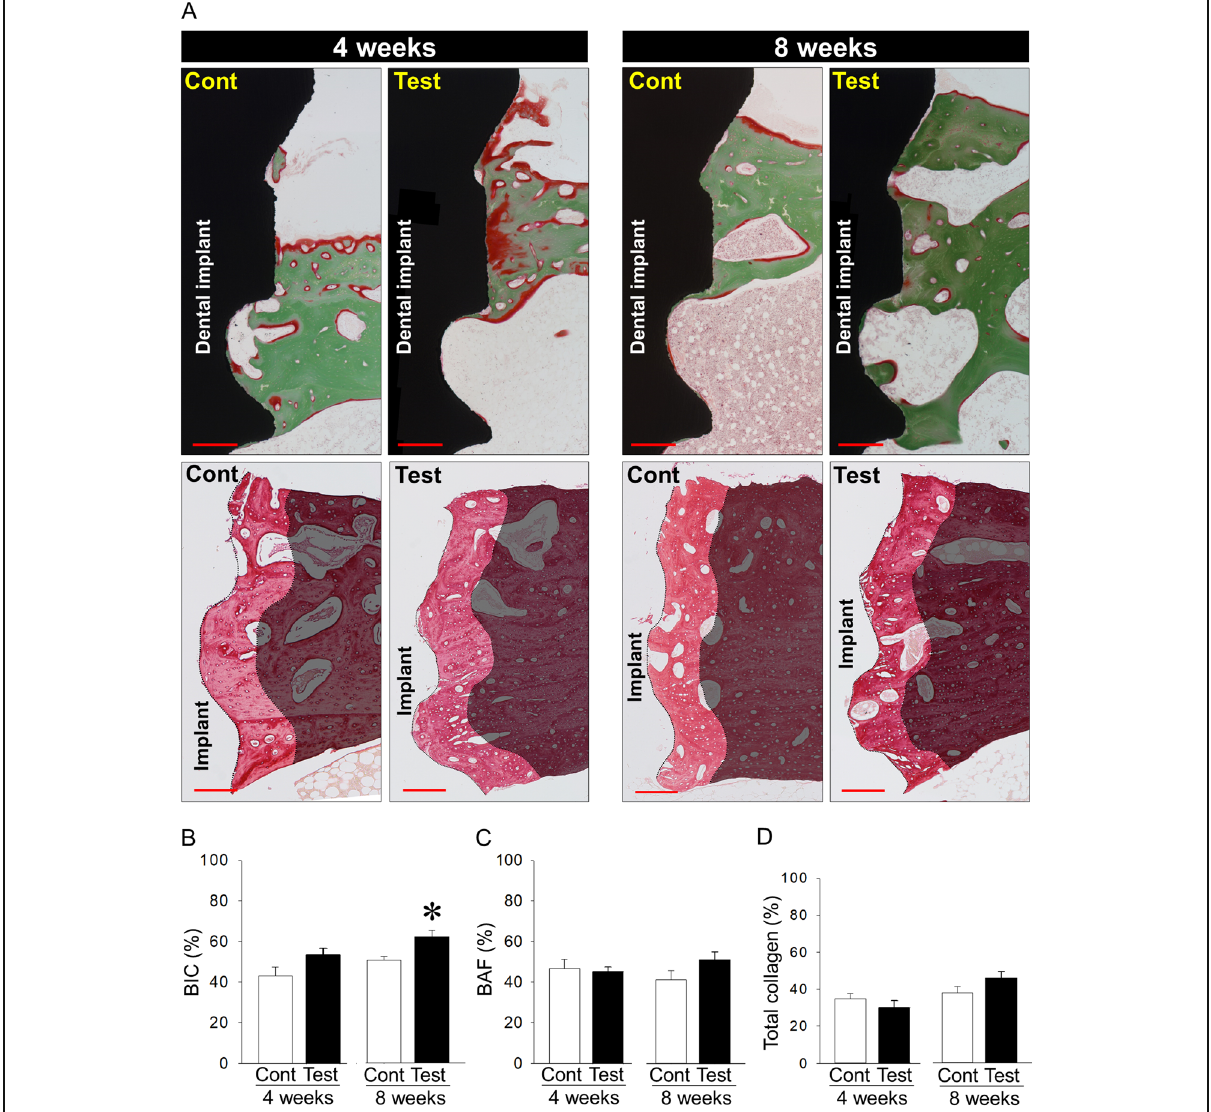
Fig. 3 a Representative Villanueva Goldner- and picrosirius red-stained images 4 and 8 weeks post-implant placement (bar, 250 μ m, Cont: control). b Increased bone-to-implant contact (BIC) in test implants 4 and 8 weeks post-implant placement when compared with each control. c , d Similar bone area fraction (BAF) and the amount of collagen in bone matrices between control and test implants. * p < 0.05, n = 7/each